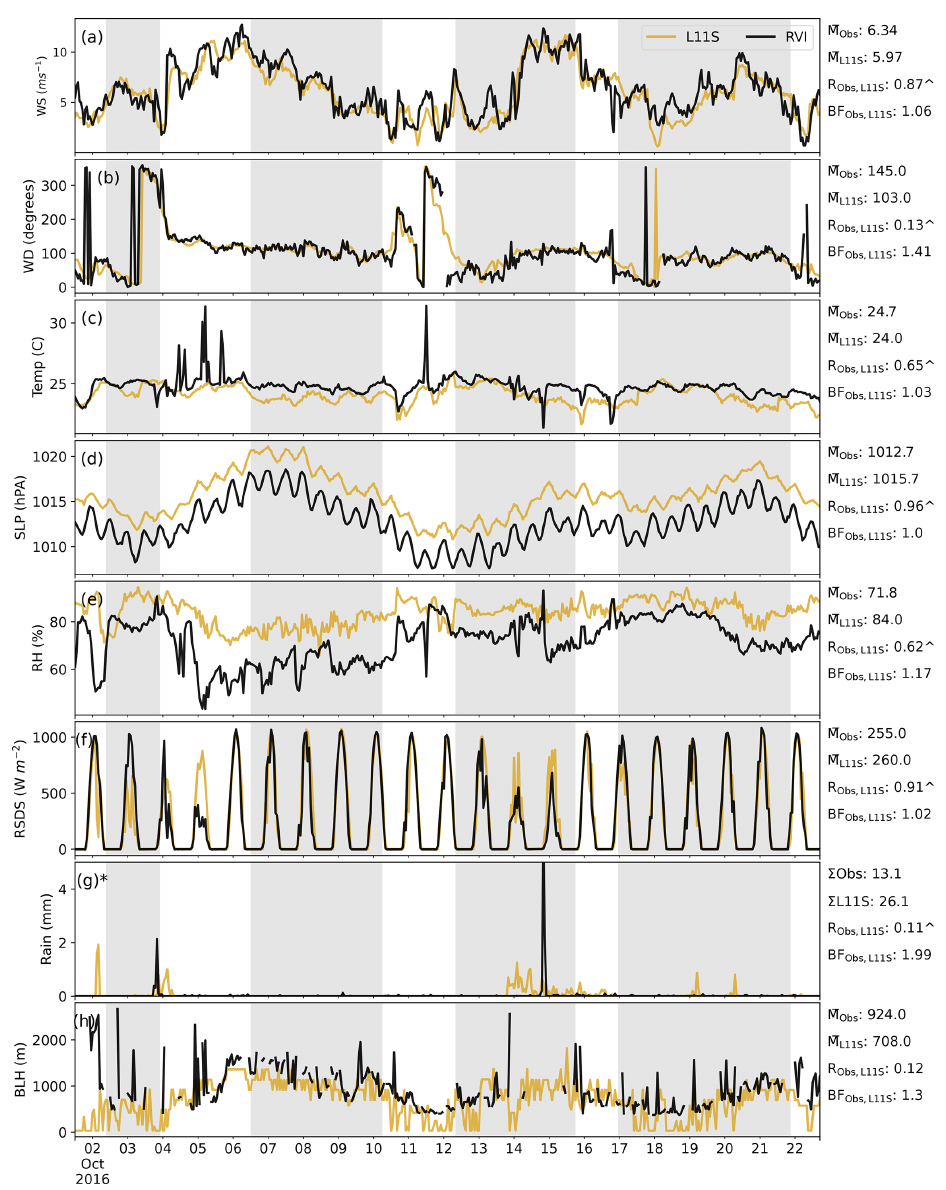
Figure C1. Time series along the RVI track (in UTC) in descending order of wind speed, wind direction, temperature, sea level pressure, relative humidity, surface incoming radiation, rainfall and boundary layer height, comparing the L11S WRF simulation (yellow) to observa- tions (black). Summary statistics are shown for the observations and L11S including the mean ( M ) (or sum (cid:54) ), the correlation ( R ) and the normalised mean bias factor. ∧ indicates where the R values are significant to the 95th percentile. The shaded grey areas in (a) – (h) represent periods when the ship was at a station. The y axis in (g) has been limited to 5mm for clarity. Observations in (h) have been filtered for when cloud was detected and subsequently excluded for the relevant